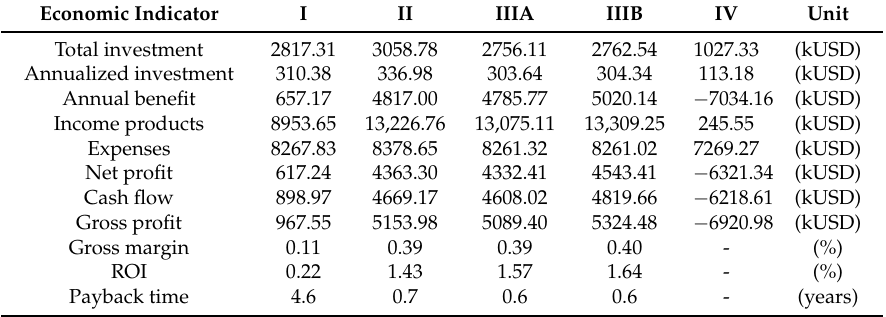
Table 5. Economic indicators for the evaluated annatto seeds-sugarcane biorefinery